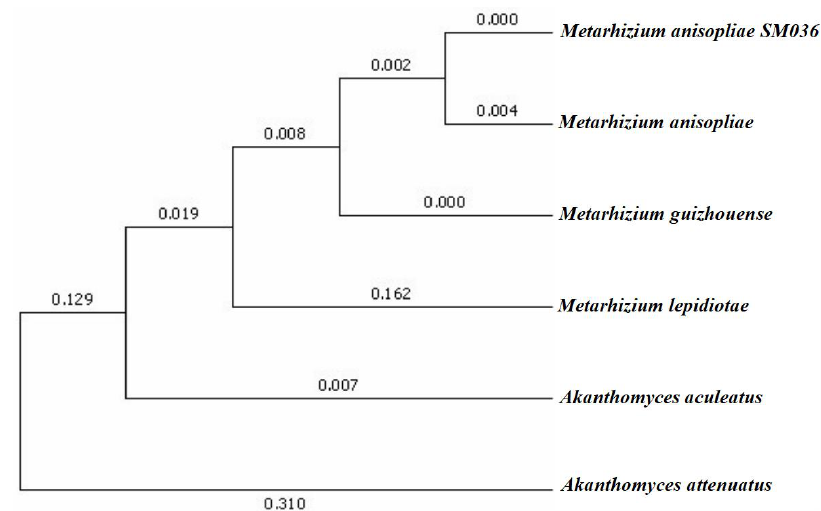
Figure 1. Neighbor-joining (NJ) tree of Metarhizium anisopliae SM036